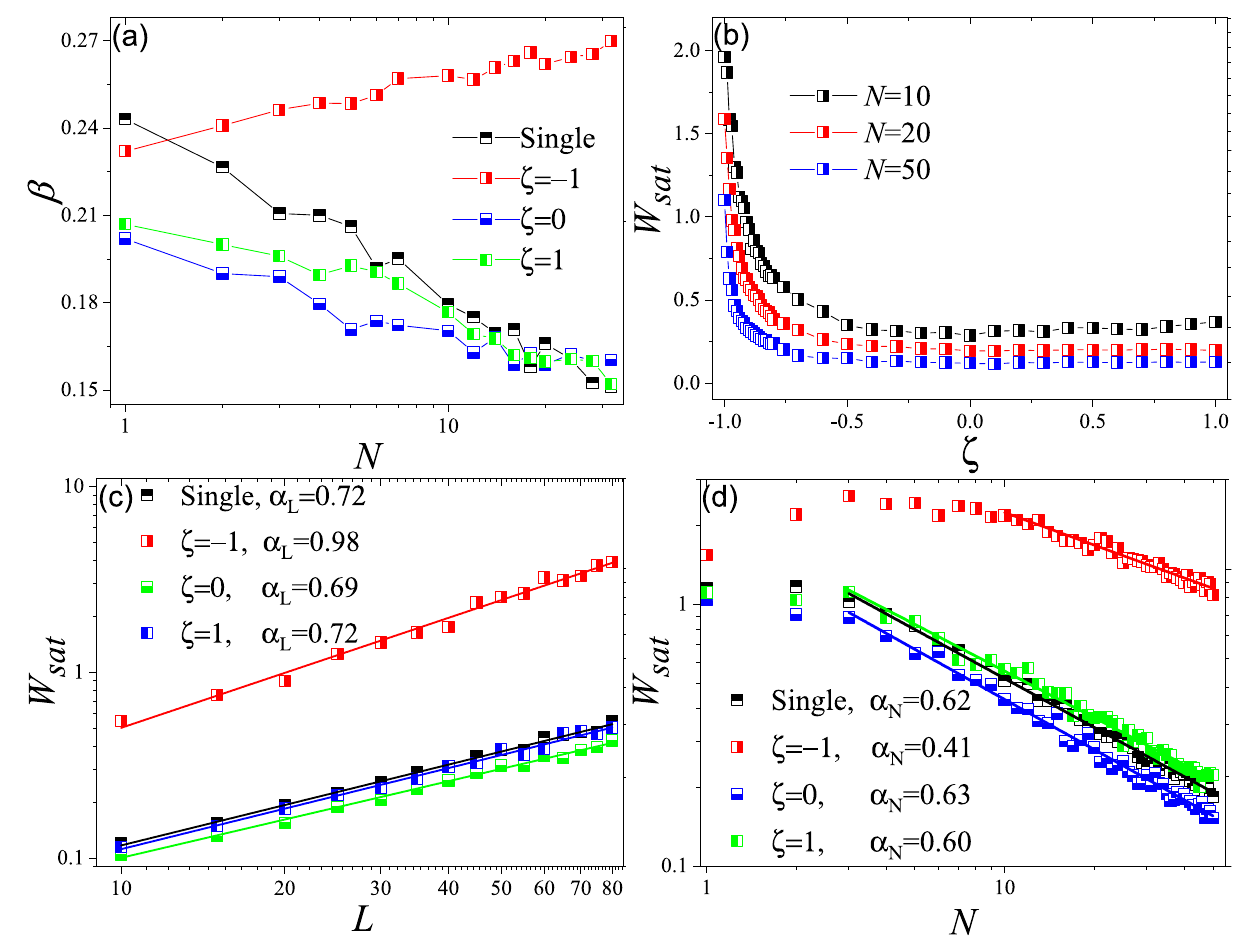
Figure 5. ( a ) Growth exponent, β versus N for the single population model and two interactive populations with different values for ζ . As this figure shows, N decreases beta only for non-competitive populations ( ζ 10 . This figure shows that for ζ ( b ) W sat versus ζ for N = means that for competitive populations, invasion front might be much rough. ( c ) W sat versus L . The slop of log / log diagram gives us the roughness exponent. ( d ) W sat versus N . For ζ 0.61 0.02 0 , we have α ζ N = ± ≥